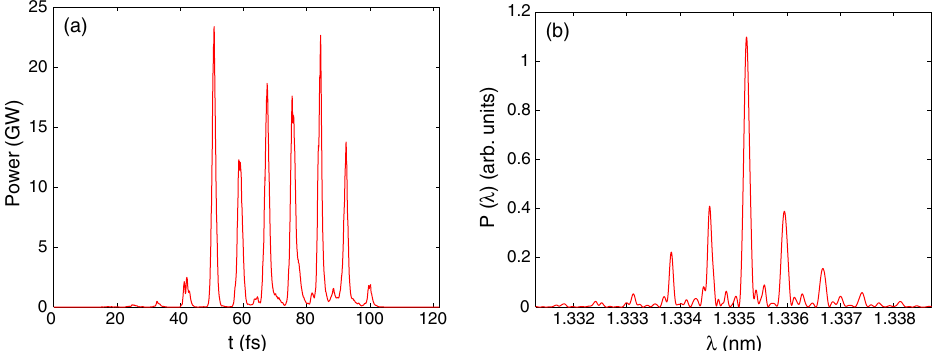
FIG. 12. FEL power and spectrum after the coherent seed is amplified by the density-modulated beam in 5 undulator